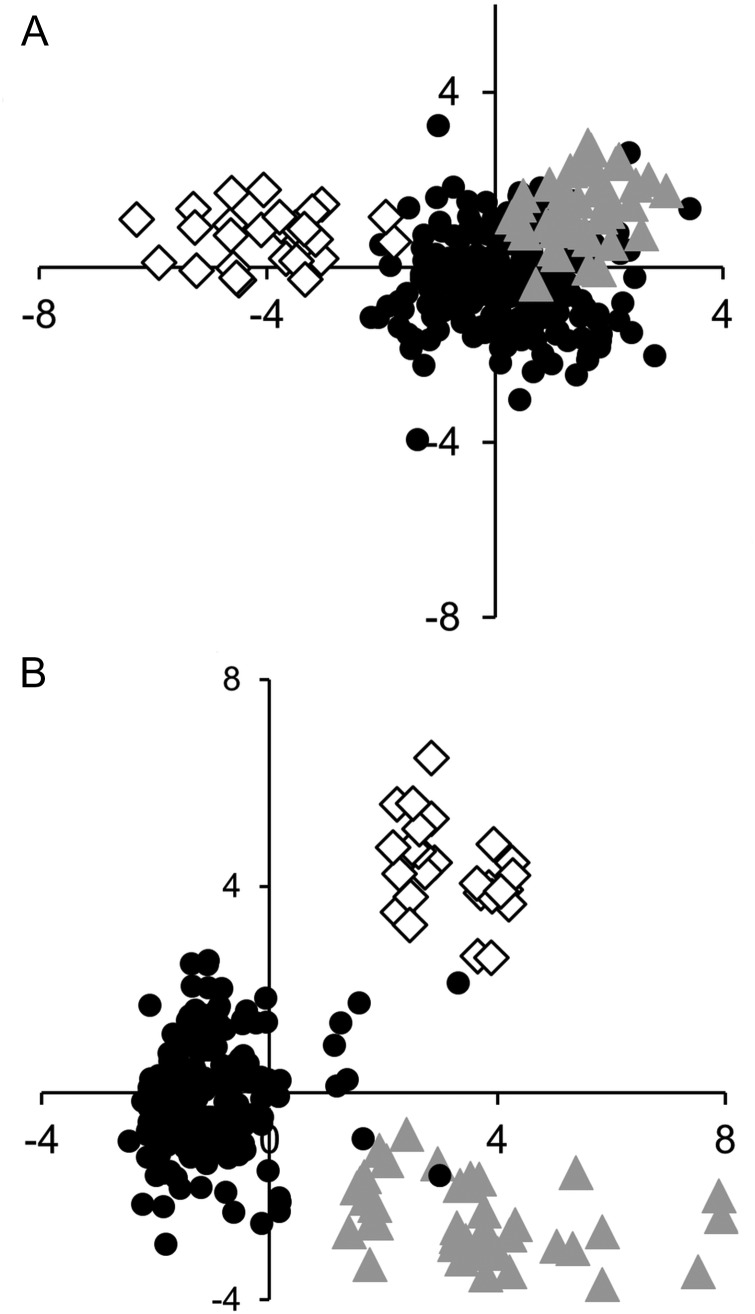
A. First two axes of a discriminant analysis of three Trochulus species based on measurements. Symbols: black circles, T. hispidus complex; white rhombs, T. striolatus subspp.; grey triangles, T. oreinos subspp. LD1 on horizontal axis, LD2 on vertical axis. Coefficients of linear discriminants (LD1, LD2): shell width −10.66, 52.96; width of umbilicus: 2.43, −12.12; shell height: −0.69, −11.39; height of last whorl: −13.33, −26.36. B. First two axes of a combined discriminant analysis of the three species based on measurements and the first three dimensions of a correspondence analysis of qualitative shell traits. Symbols and axes as in A. Coefficients of linear discriminants (LD1, LD2): dimension 1: −1.84, 0.61; dimension 2: 0.57, 0.29; dimension 3: −0.85, −0.26; shell width: 18.93, 11.88; width of umbilicus: −4.85, −0.59; shell height: −4.75, 2.33; height of last whorl: −5.08, 9.64.